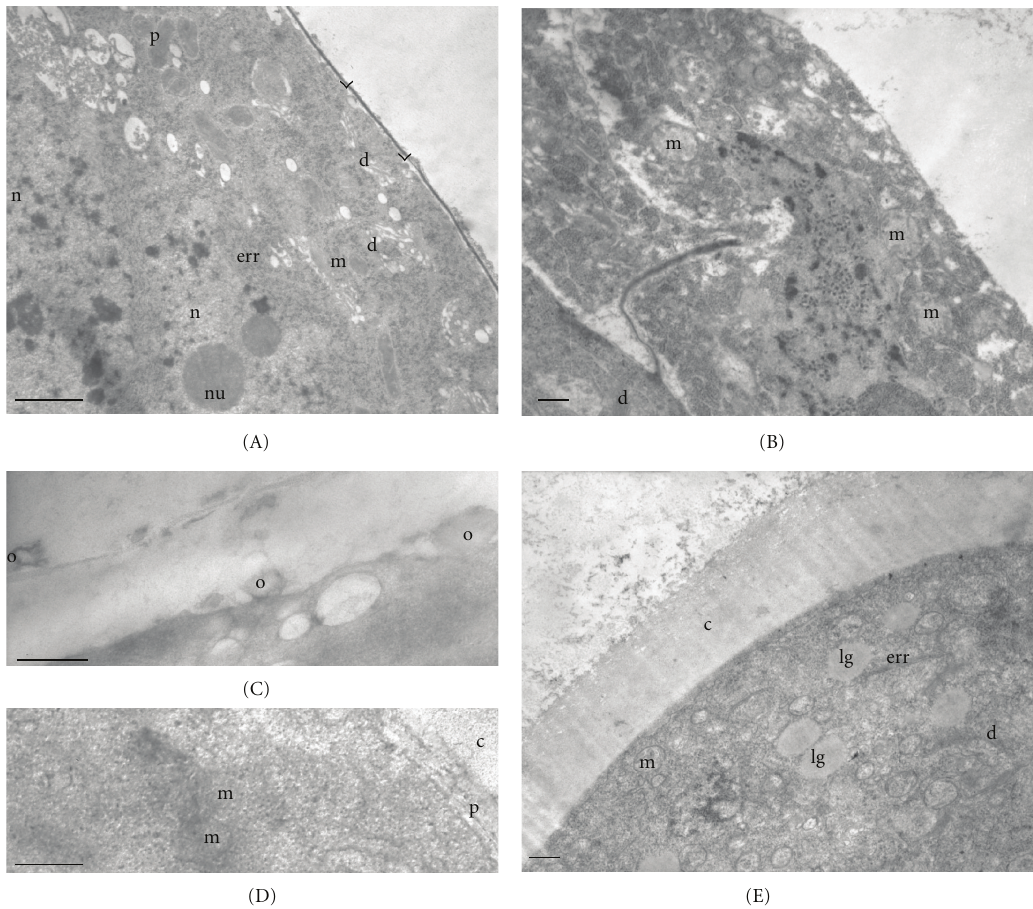
Figure 2: Stage 2: microspore tetrads. (A)–(C) Colletia paradoxa. (D)-(E) Discaria americana. (A) Tapetal cell at young microspore tetrad stage. Proorbicules (arrow head) are observed. Cytoplasm with endoplasmic reticulum of rough type (err), plastids (p), mitochondria (m), dictyosomes (d), and two nuclei (n), and nucleoli (nu). (B) Details of the tapetal cytoplasm and wall at an advanced microspore tetrad stage. Orbicules (o) are observed in the inner and the outer tapetal wall, which is partly degraded. Dictyosomes (d) and mitochondria (m) are also present. (C) Microspore with many mitochondria (m) and dictyosome (d). Callosic wall and primexine are observed. (D) Tapetal cell with many mitochondria (m) and dictyosomes (d). Cell wall degraded. (E) Microspore with mitochondria (m), lipid globules (lg), dictyosomes (d), endoplasmic reticulum of rough type (err), and callose (c). Scale bar: (A) 1.3 µ ; (B) 300 nm; (C) 400 nm; (D)-(E) 500